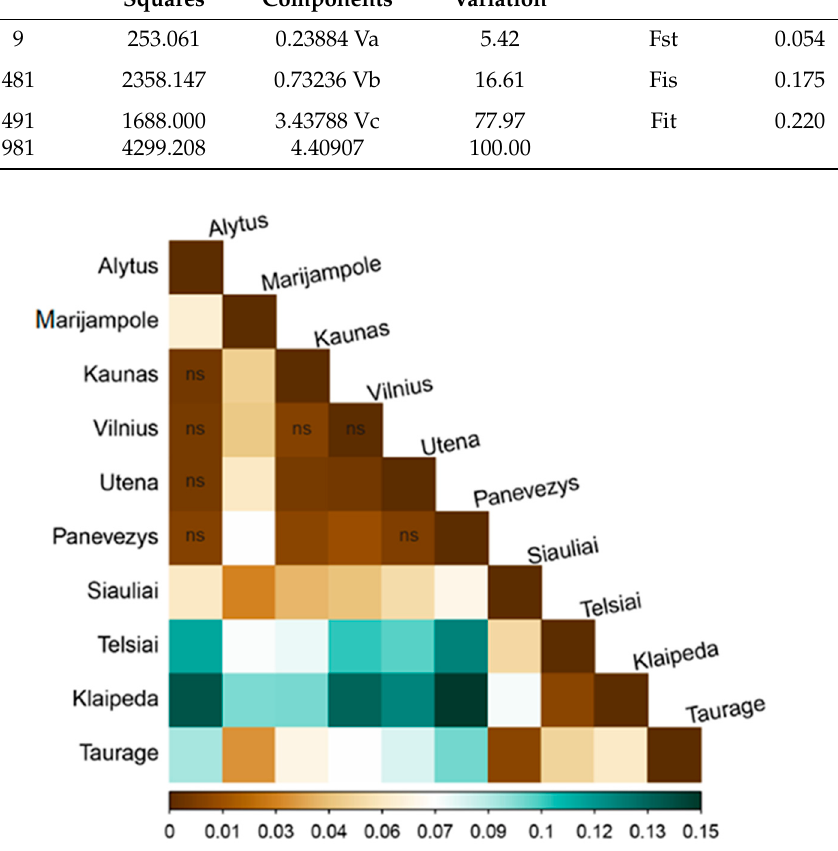
Figure 2. Pairwise Fst distances between studied wild boar sampling sites. The colour gradient represents the degree of genetic differentiation: low for Fst < 0.05, moderate for 0.05 < Fst < 0.15, high for 0.15 < Fst < 0.25 and very high for Fst > 0.25, according to the criteria for genetic differentiation of Wright (1978) (scale at the bottom of the figure (ns = not significant, blank significant p < 0.05, pairwise populations Fst value)).